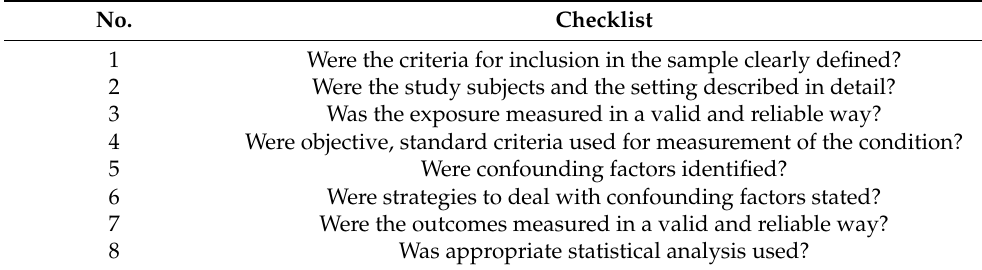
Table 1. Checklist for analytical cross-sectional studies in JBI Critical Appraisal Tool